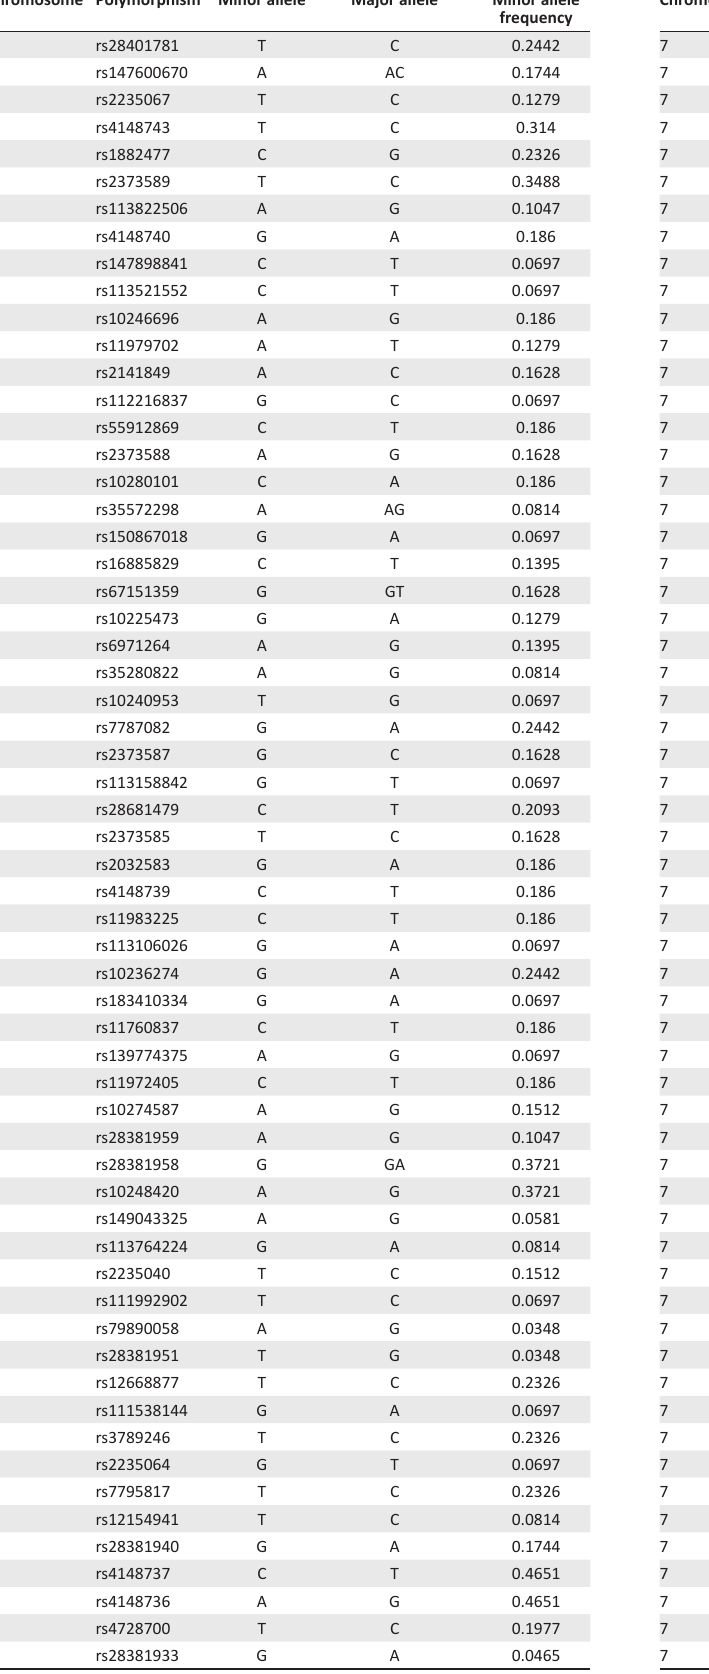
Table 1-A1 continues on the next page →Table 1-A1 continues in the next column